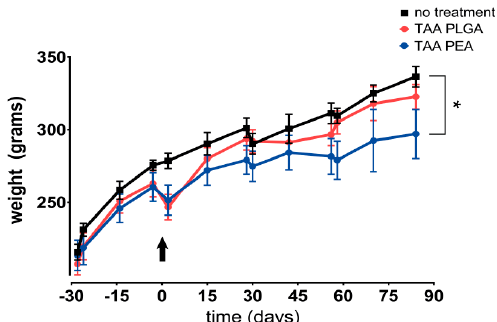
Figure 5. Body weight gain during the 84 day follow-up of the study. Animals are intra-articularly injected with TAA-loaded PLGA microspheres (red) or TAA-loaded PEA microspheres (blue) and compared to untreated animals (black). In the immediate period after local TAA injection, PEA-treated and PLGA-treated animals reduced in 3% and 7% body weight, respectively. Arrow indicates time point (d0) of intra-articular microsphere injections. Data represent mean ± standard deviation (SD), * p < 0.05.